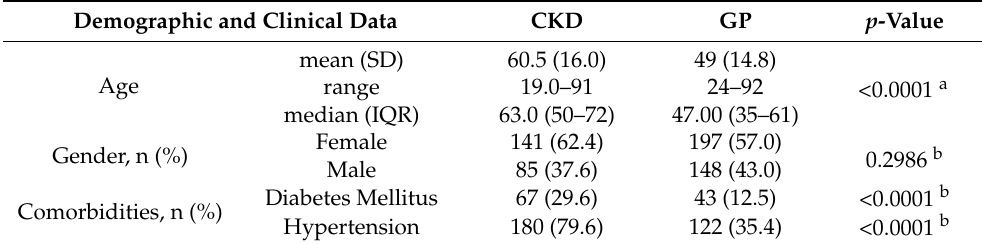
Table 4. Demographic comparison of CKD and GP